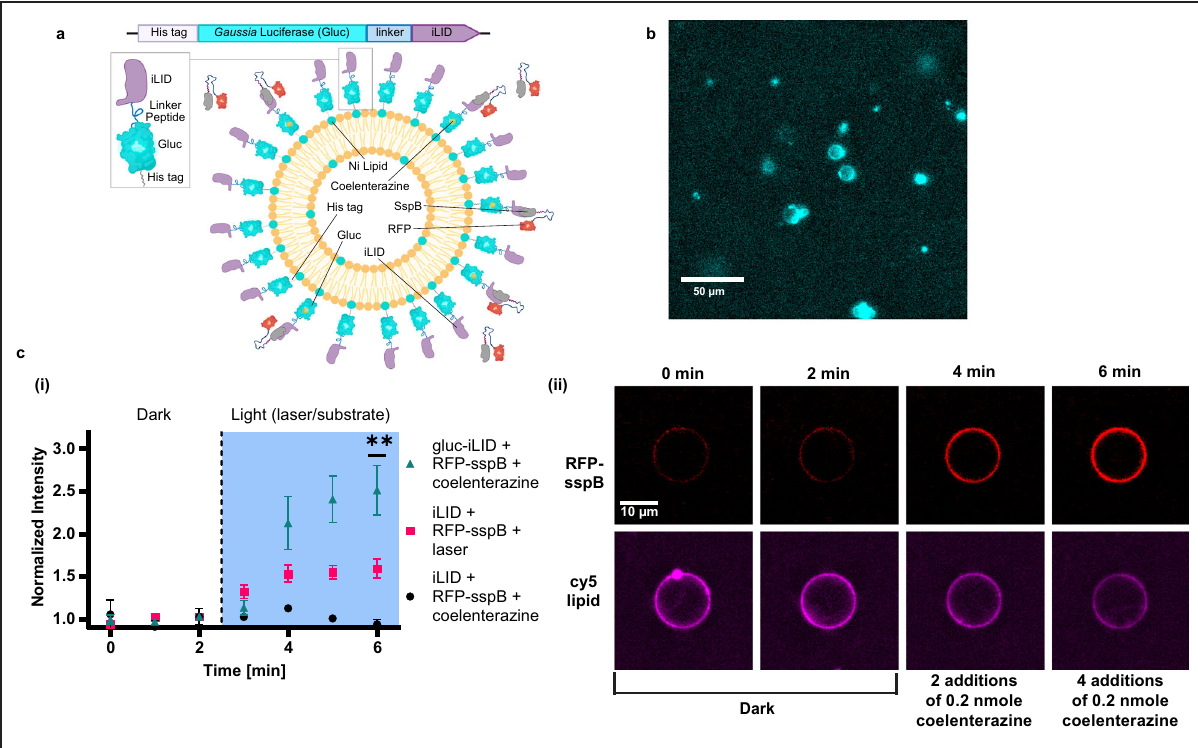
Fig. 5 Bioluminescence-activated membrane recruitment in synthetic cells. a A block diagram of the Gaussia luciferase (Gluc)-iLID fusion protein elements. Below, a schematic representation of protein recruitment to the synthetic cell membrane by hetero-dimerization of the fusion protein Gluc-iLID with RFP-sspB. b Microscopy image of luciferase light emission from synthetic cells with membrane-bound Gluc-EL222 after coelenterazine addition. This experiment was reproduced n = 5 times. c (i) Membrane recruitment of RFP-sspB with iLID or Gluc-iLID using 488 nm laser illumination or by addition of coelenterazine to activate the bioluminescent reaction. RFP intensity is normalized to the average intensity of each cell in the dark conditions. Data is expressed as a mean ± s.e.m. Welch ’ s two-tailed t -test P -values; **p = 0.0092, ***p = 0.0001, for comparison of Gluc-iLID vs. iLID activated by laser and iLID supplemented with coelenterazine at t = 6 min, respectively. (ii) Representative single-cell images of RFP-sspB recruitment to a synthetic cell with membrane-bound Gluc-iLID in the dark and after two and four doses of 0.2 nmol coelenterazine (Top row). Bottom row displays the fl uorescence of the synthetic cell ’ s DOPE-Cy5 lipid that composed 0.5 mol% of the membrane ( n = 3 for iLID + coelenterazine, n = 11 for iLID + laser, n = 14 for Gluc-iLID + coelenterazine). Source data are provided as a Source Data fi